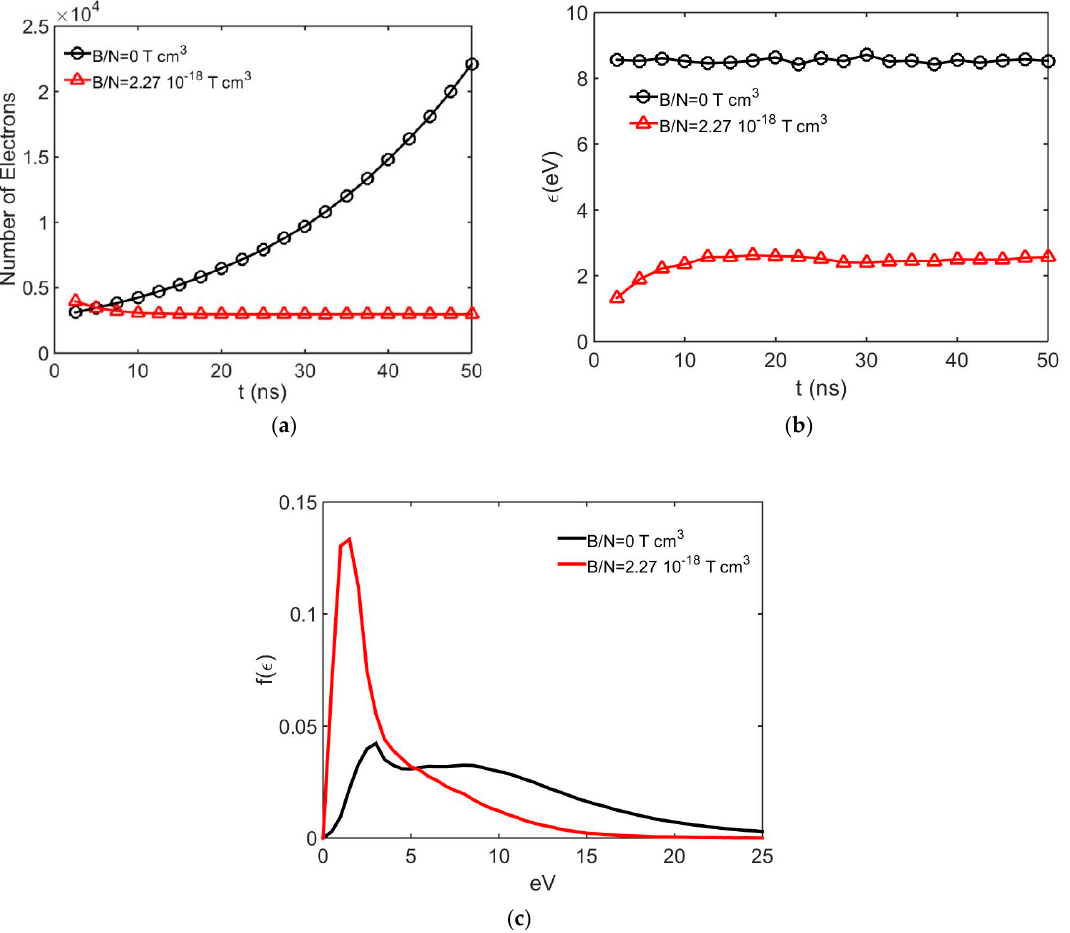
Figure 8. A 0.25% SF 6 + 99.75% N 2 mixture at 400 Td with different magnitudes of crossed magnetic field: ( a ) number of electrons; ( b ) electron mean energies; ( c ) electron energy distribution functions (Corresponding magnetic field strength; Black line: H = 0 A/m, Red line: H = 6.00 × 10 4 A/m).